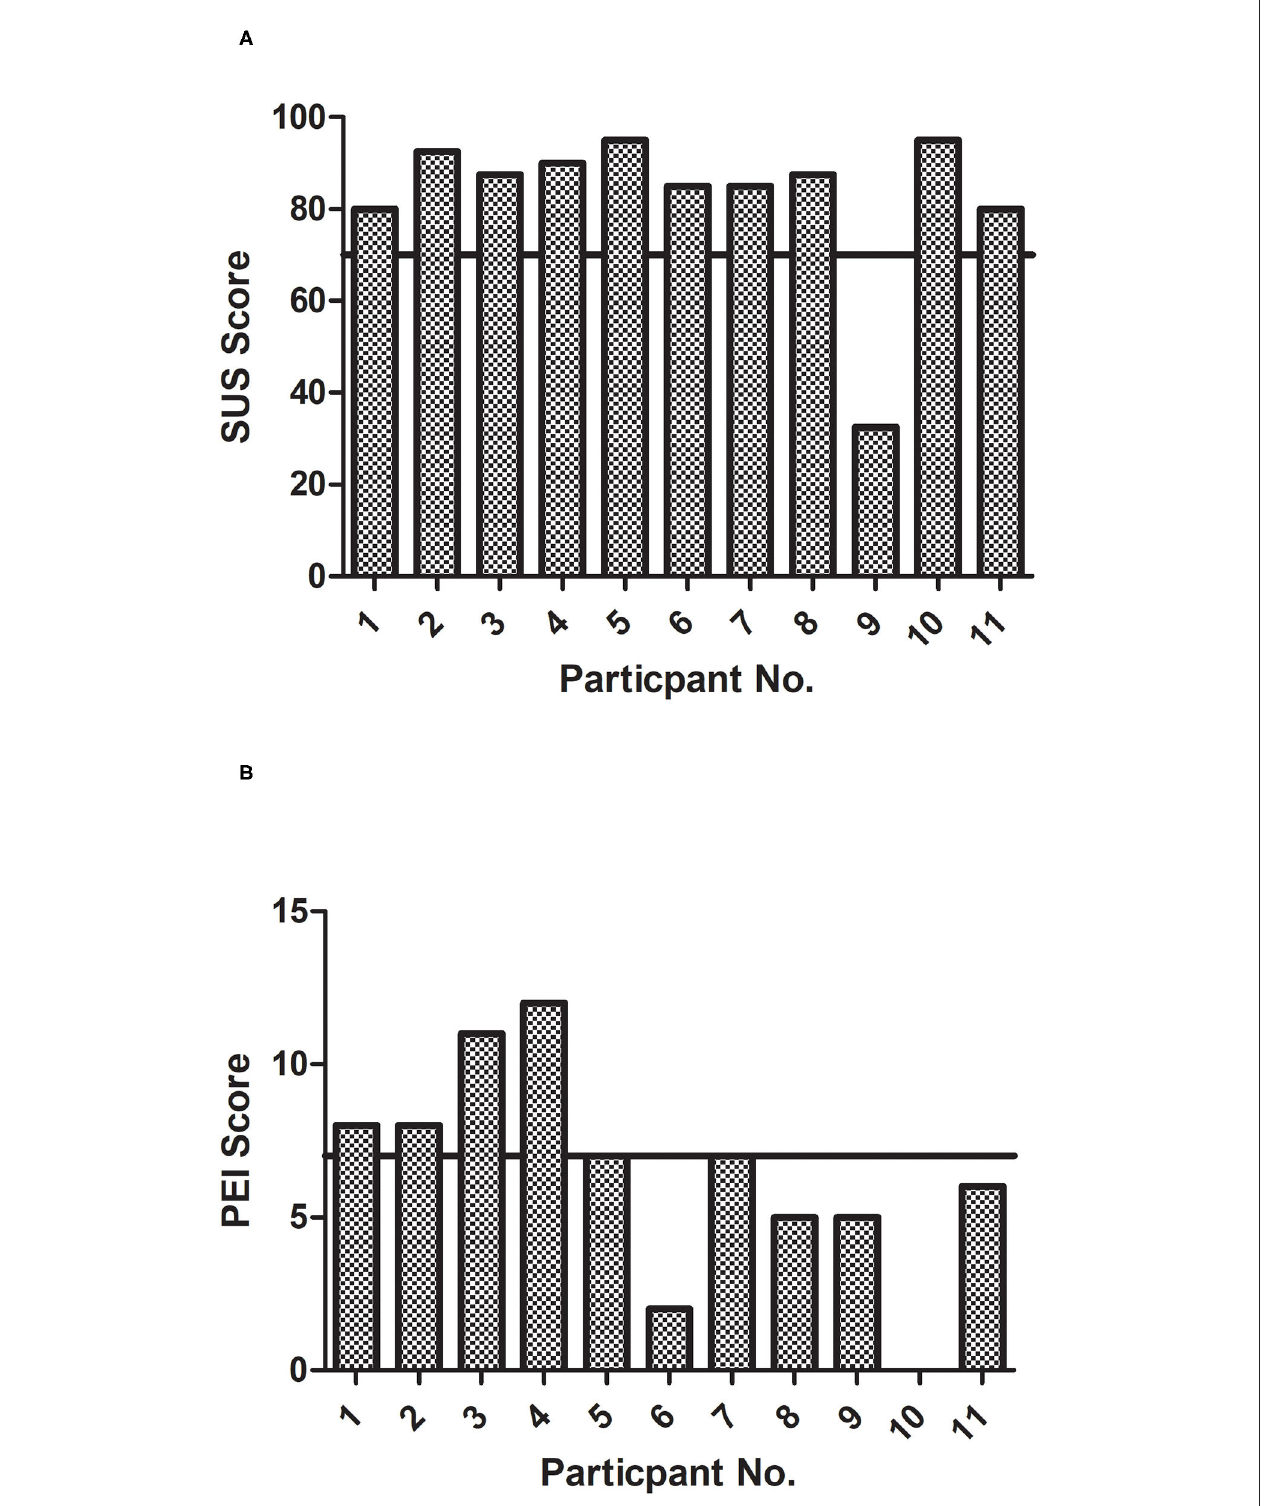
FIGURE 2 | (A) System usability scale scores for each participant. The cut-off point of acceptable usability is shown on the y axis at 70/100 and (B) patient enablement instrument scores for each participant. The acceptable cut-off score of 7 is depicted by the line on the y axis at 7/12.